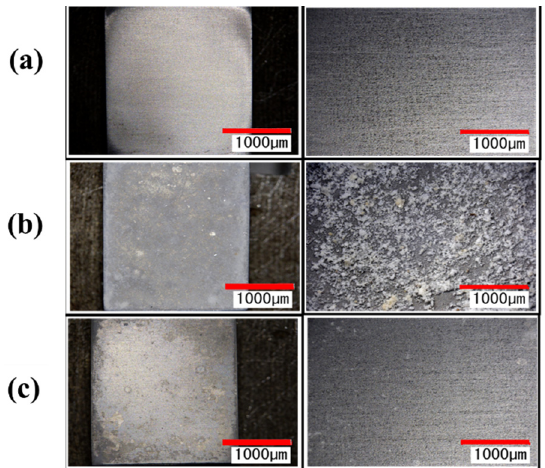
Figure 14. The images of the surface of the test piece before and after the deposition of the tartar model and before and after the blasting of the agar particles, are shown. ( a ) is the sample surface (polished surface) before the tartar model was deposited, ( b ) is the sample surface of tartar model, and ( c ) is the sample surface after the blasting by WH-706.